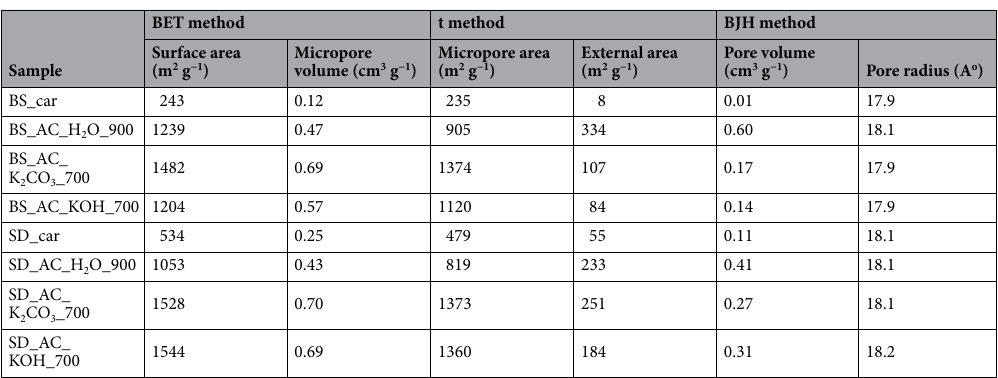
Table 2. Surface texture properties BS and SD-carbon samples activated with different activators under optimized conditions.